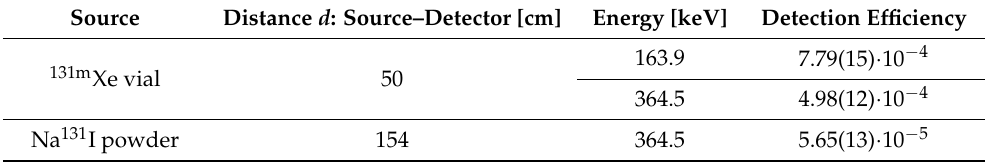
Table 1. Absolute efficiencies for 163.9 keV and 364.5 keV (Canberra XtRa detector, model GX6020).